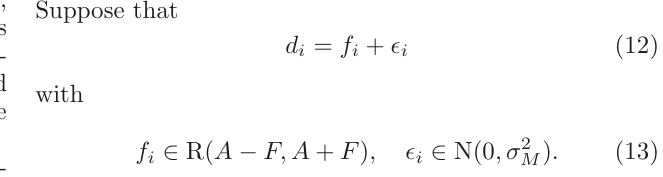
( F | f ), Figure 2 (solid curve), is the distribution defined by F 0 and A 0 in (10) and ignores measurement uncer- tainty. Compared with p ( F | f ) in Figure 1, the cut-off is less abrupt due to the fact that A is also uncertain. The mean of this distribution is mF 0 / ( m − 2) = 0 . 0115 mm.